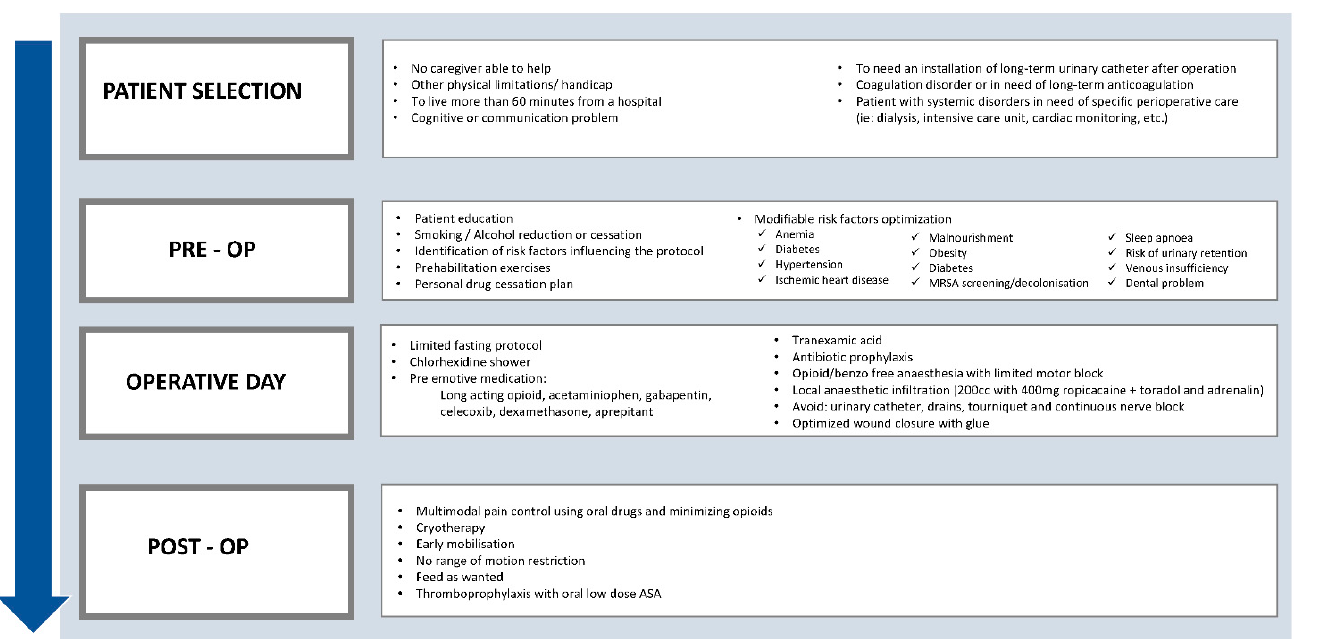
Table 1. Complications rates per group (Control vs. ERAS short-stay) according to the Clavien- Dindo classification [7].